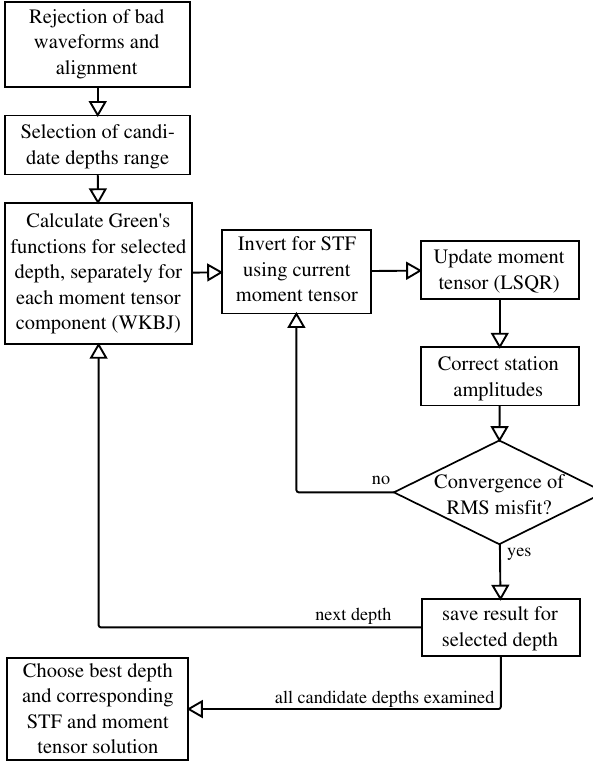
Fig. 4. Flowchart of the source inversion procedure as described in (Sigloch and Nolet,